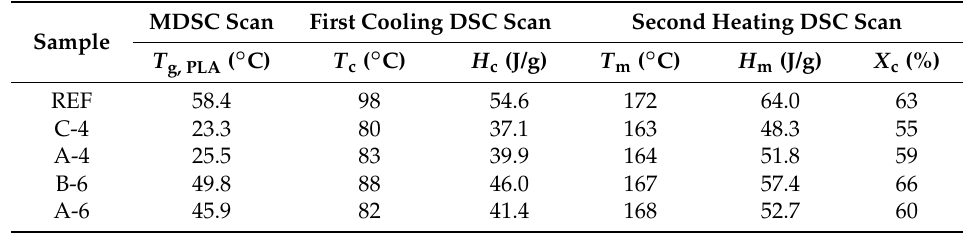
Figure 6. Reversing heat capacity gained from Modulated Differential Scanning Calorimetry (MDSC) scan of non-plasticized reference sample (REF) and PHB/PLA/Plasticizer (where the plasticizers are: C-4, A-4, B-6, and A-6). Table 2. MDSC and DSC parameters of PHB/PLA/Plasticizer samples and non-plasticized